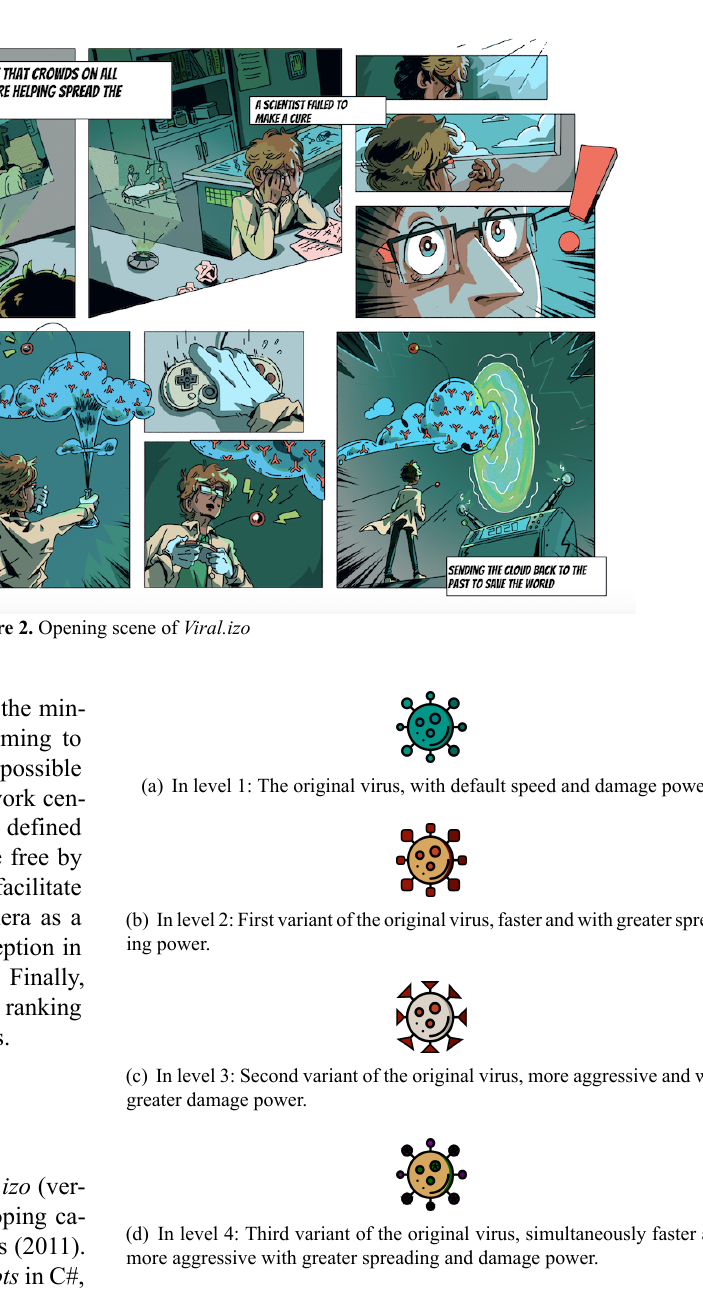
Figure 3. The main enemies in the Viral.izo game: the original virus, its three variants, and the